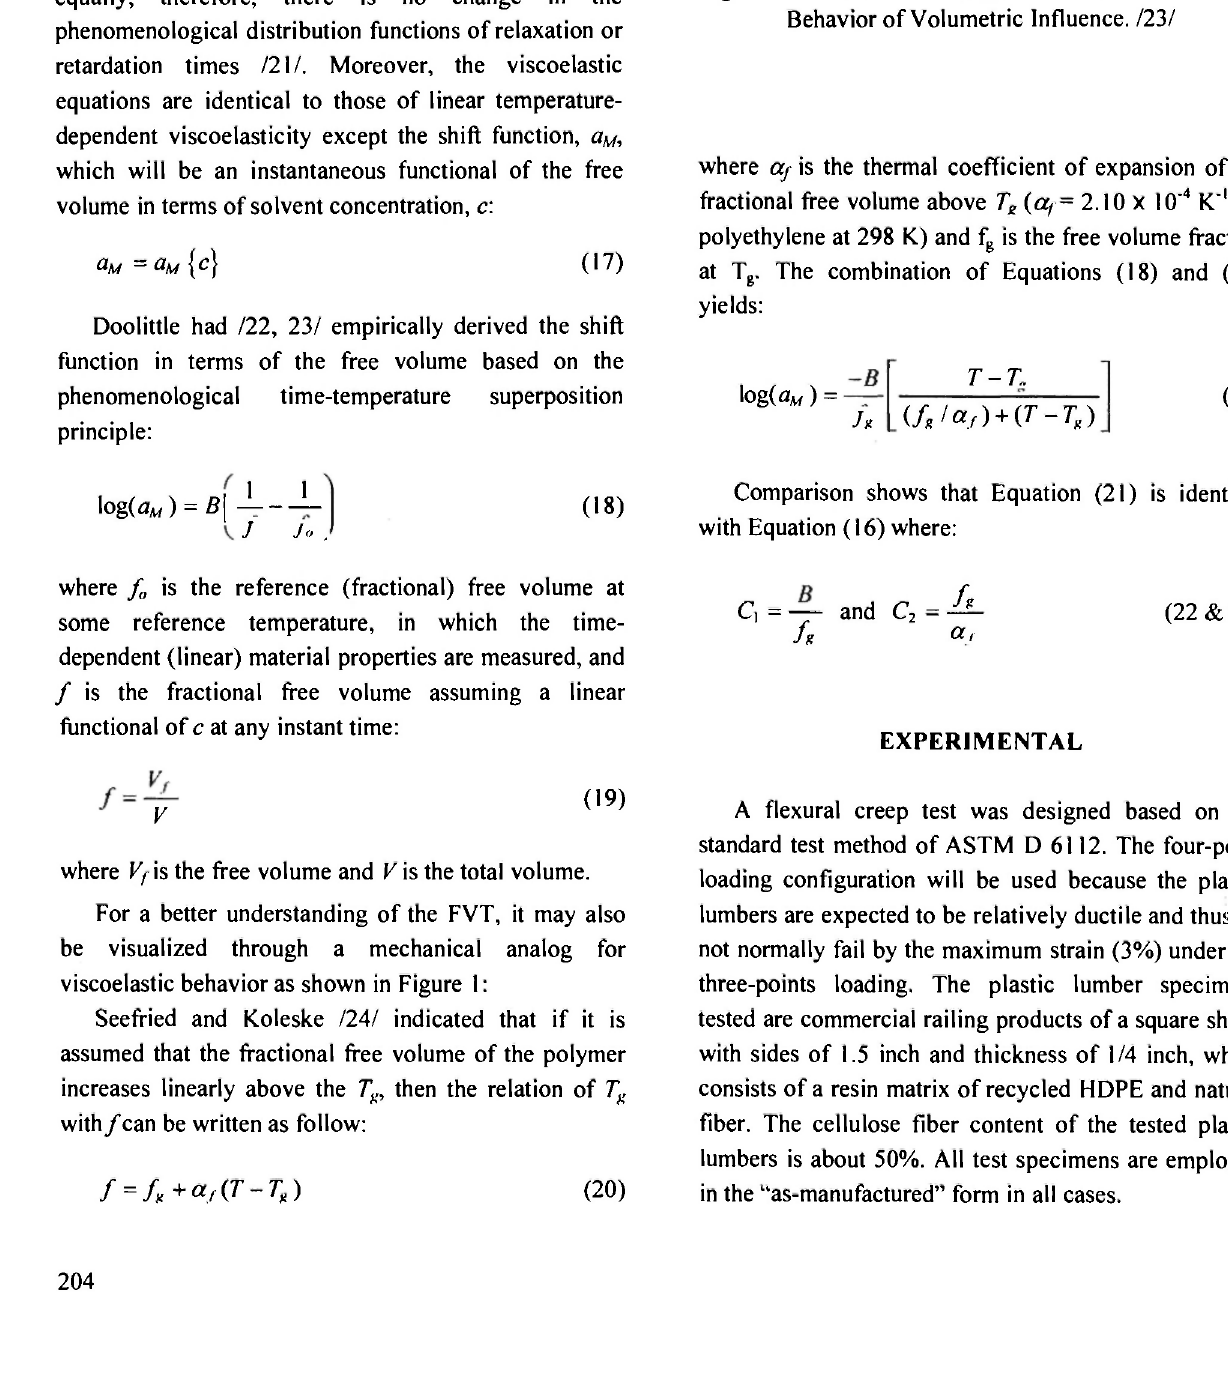
Fig. 1 : Mechanical Analogue of the Constitutive Behavior of Volumetric Influence.